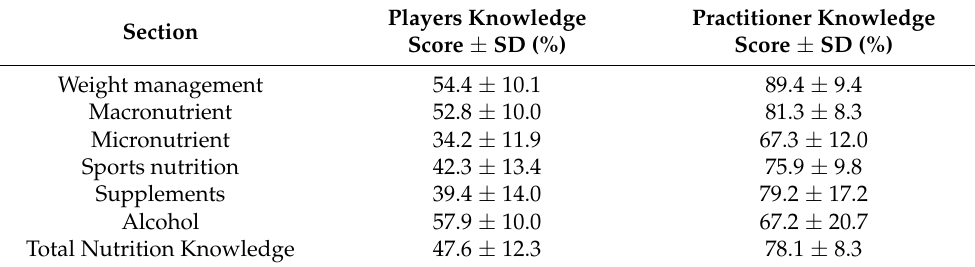
Table 2. Mean sport nutrition knowledge scores of athletes ( n = 100) and practitioners ( n = 8) for each section of the nutrition knowledge questionnaire.